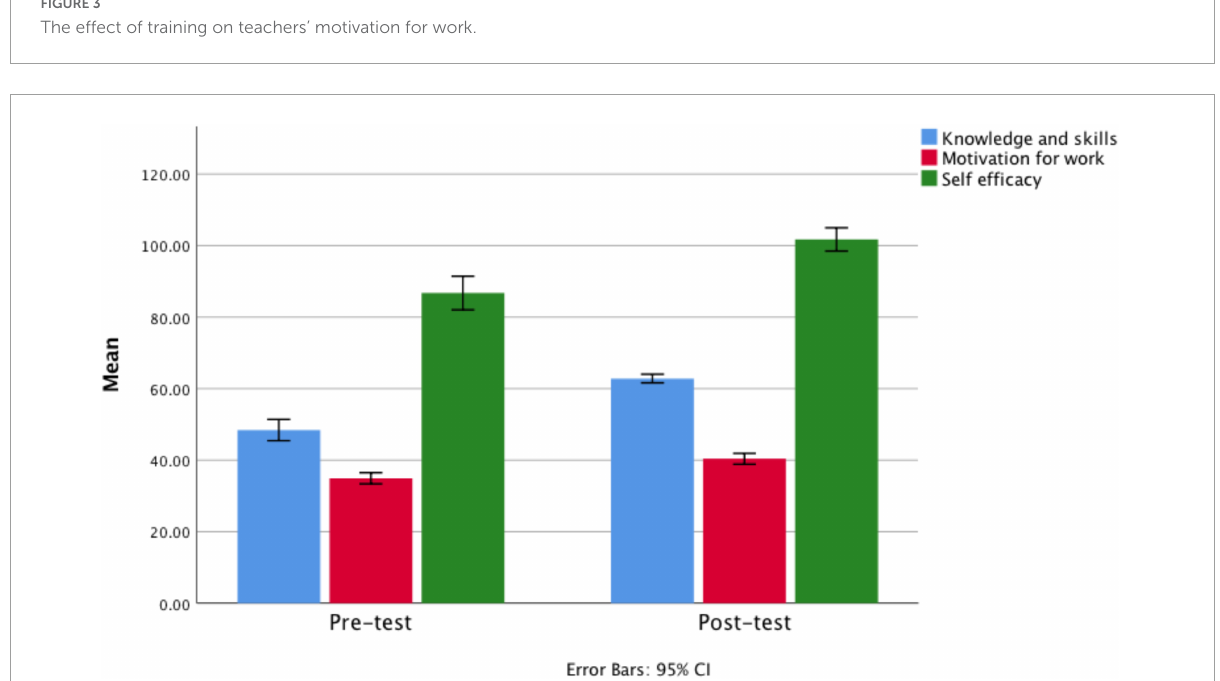
FIGURE4 The effect of training on knowledge and skills, self-efficacy, and motivation for work